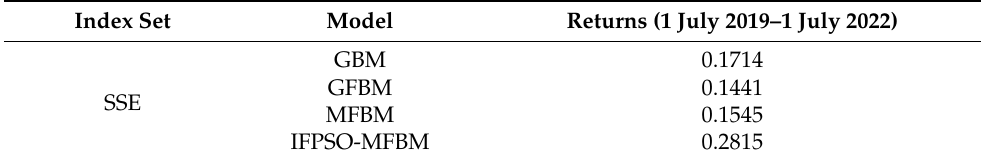
Table 5. Comparative analysis of SSE index returns under four models.